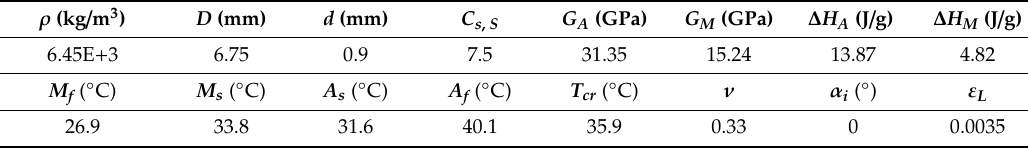
Table 2. Mechanical properties of the test